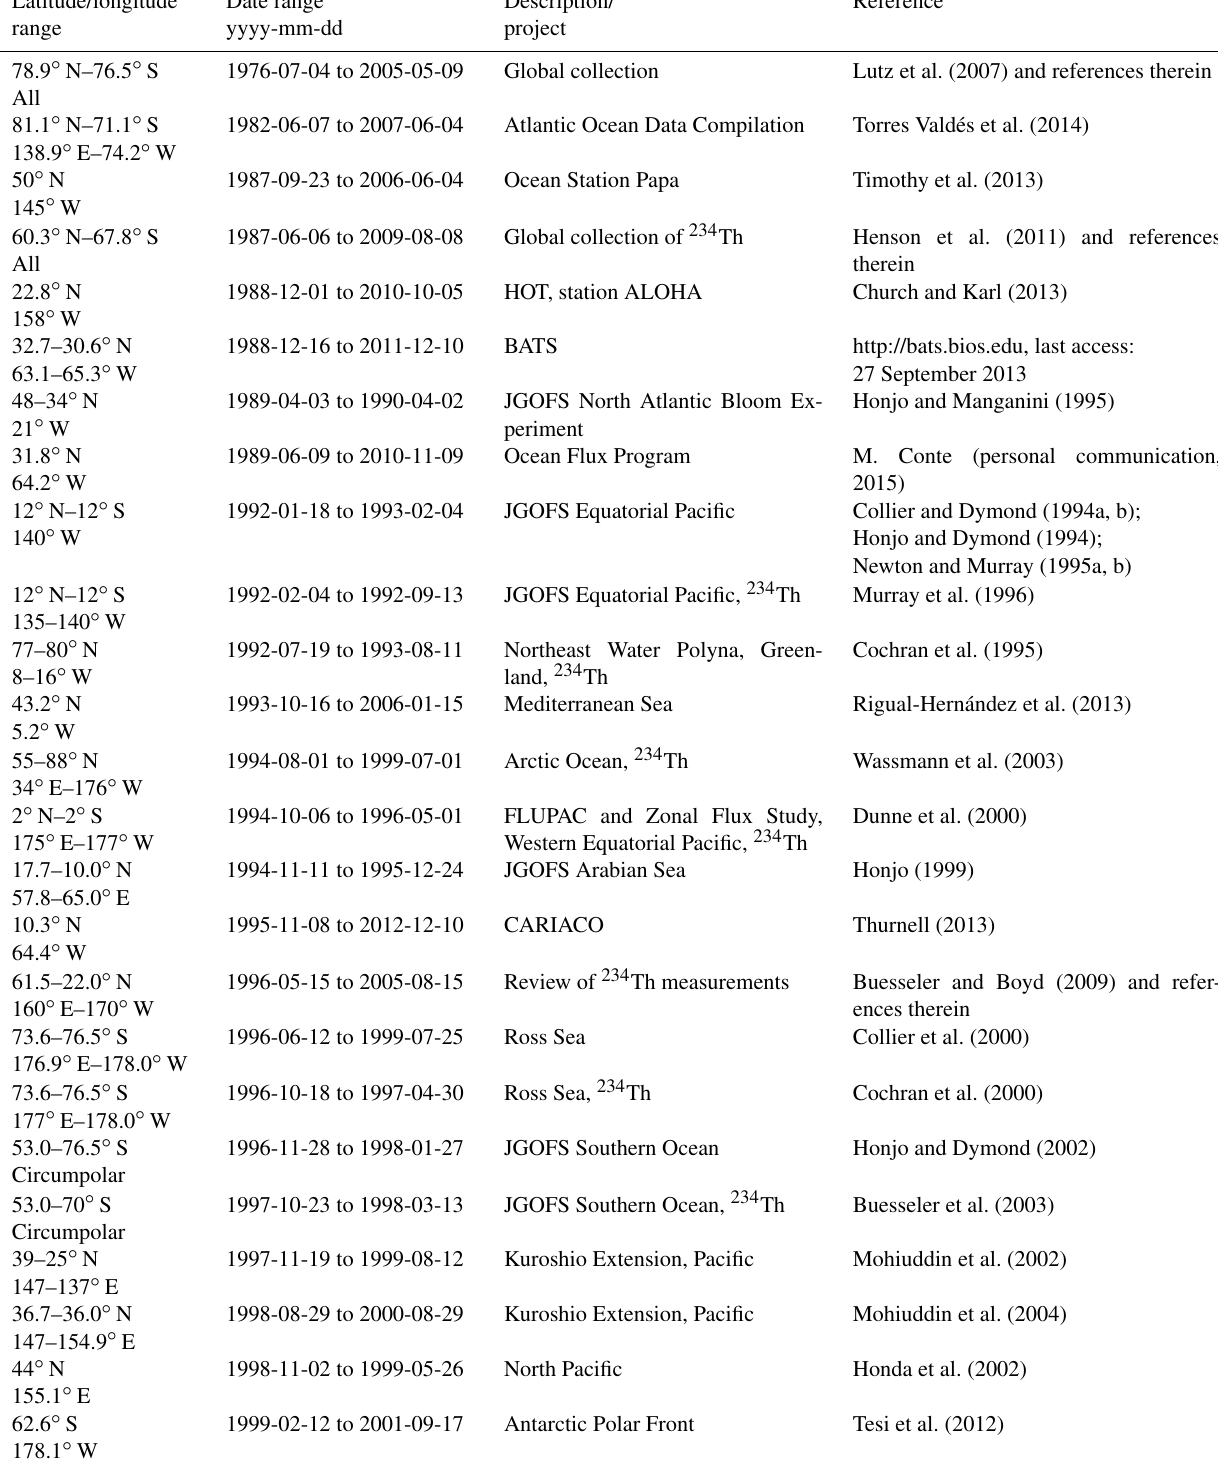
Table 2. Summary of data sources for POC flux from sediment traps and 234 Th, the latter indicated in the description when applicable. Date ranges are from first deployment to last retrieval for a given data set, but do not necessarily indicate a continuous time series. Sources are listed in order of first